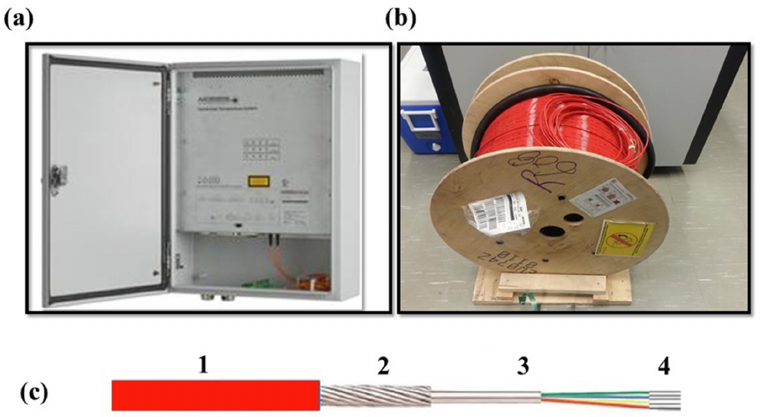
Figure 2. ( a ) The DTS instrument and the ( b ) fiber optic cable spool used in this experiment. The BRUsteel fiber optic cable composition is shown in ( c ), including (1) the nylon jacket, (2) the inter-laced steel wires, (3) the stainless-steel loose tube filed with gel, and (4) the four multimode fibers. The information collected from the technical spec-sheet of the BRUsteel fiber cable (http://www.bruggcables.com).